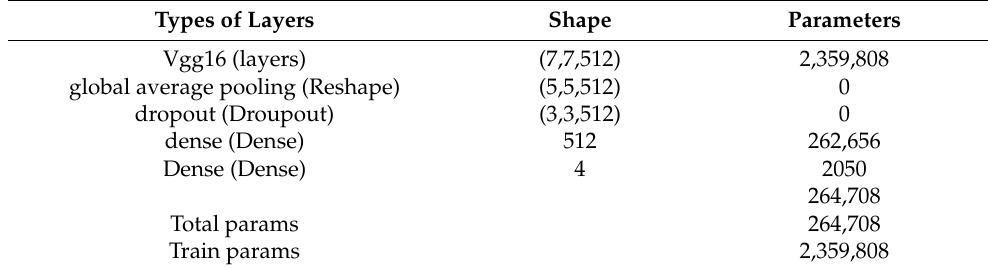
Figure 3. Confusion matrix of Proposed SCDNet. Table 2. Summary of proposed SCDNet .